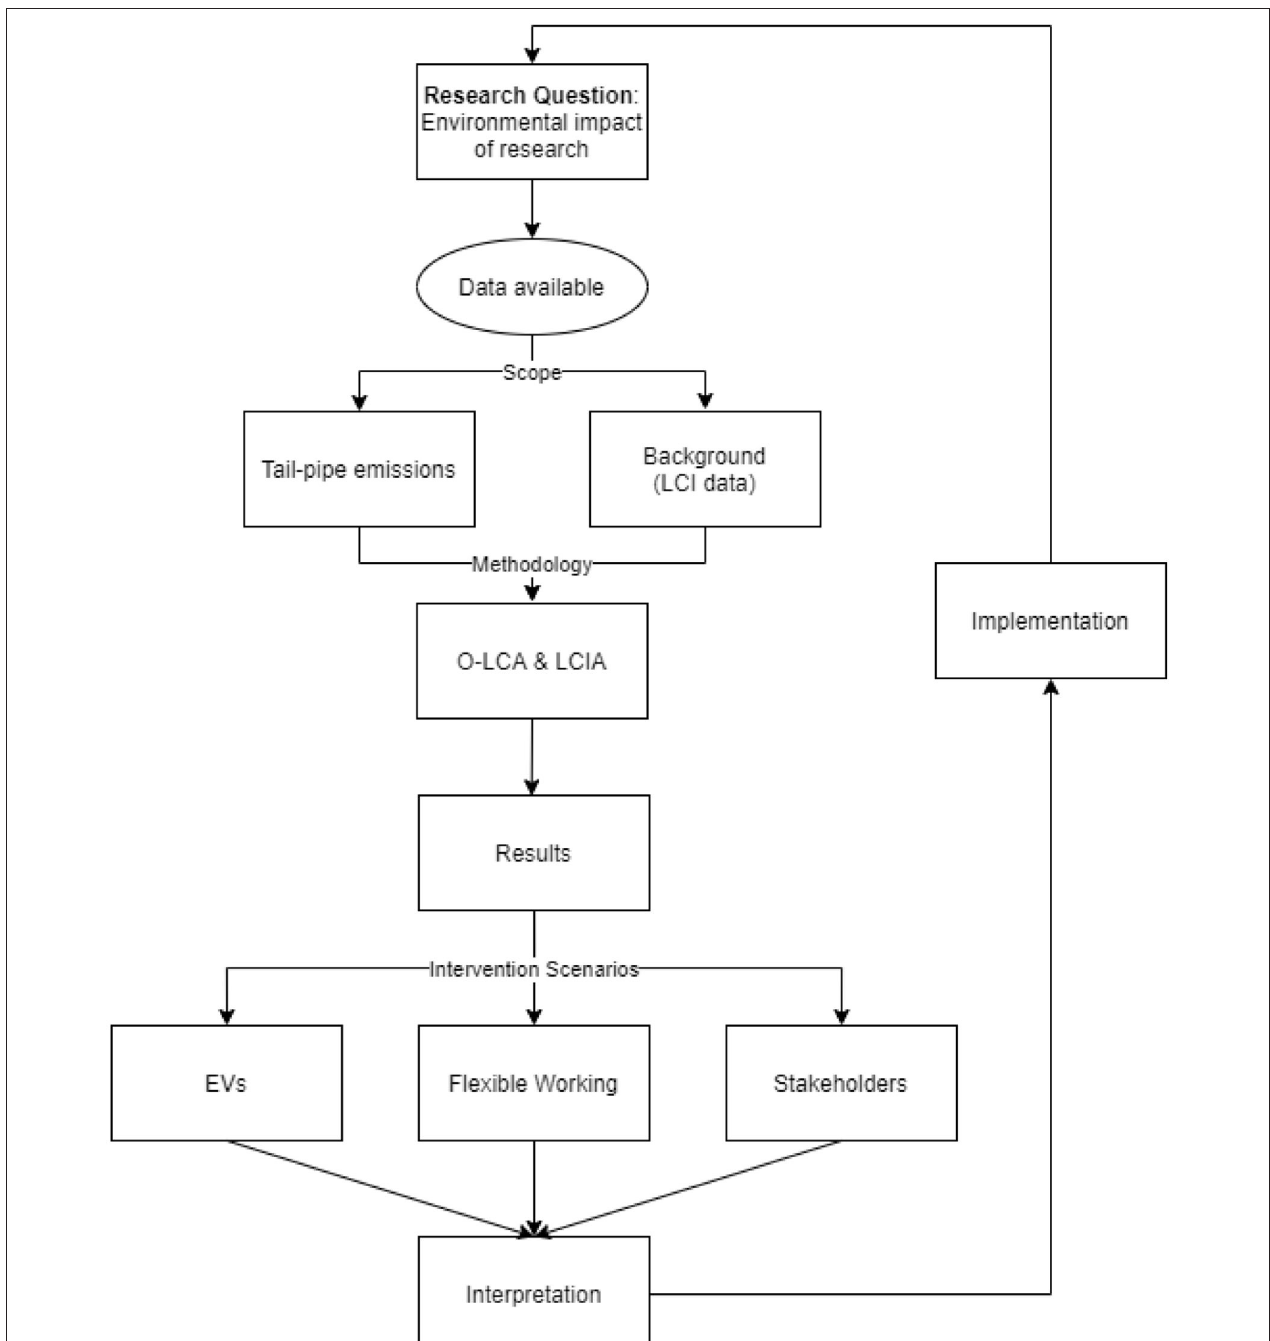
FIGURE 2 | The conceptual framework of the presented case